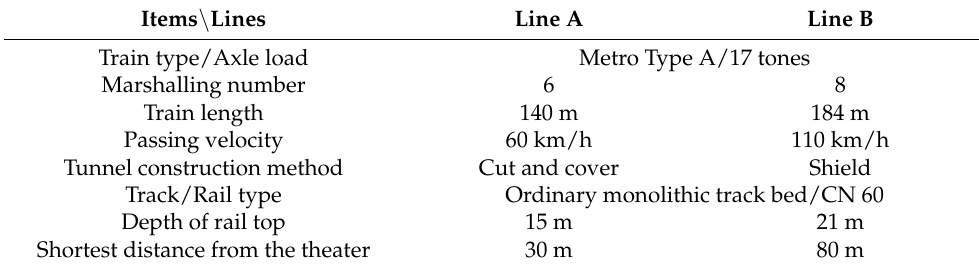
Table 3. Major configurations of Line A and Line B.